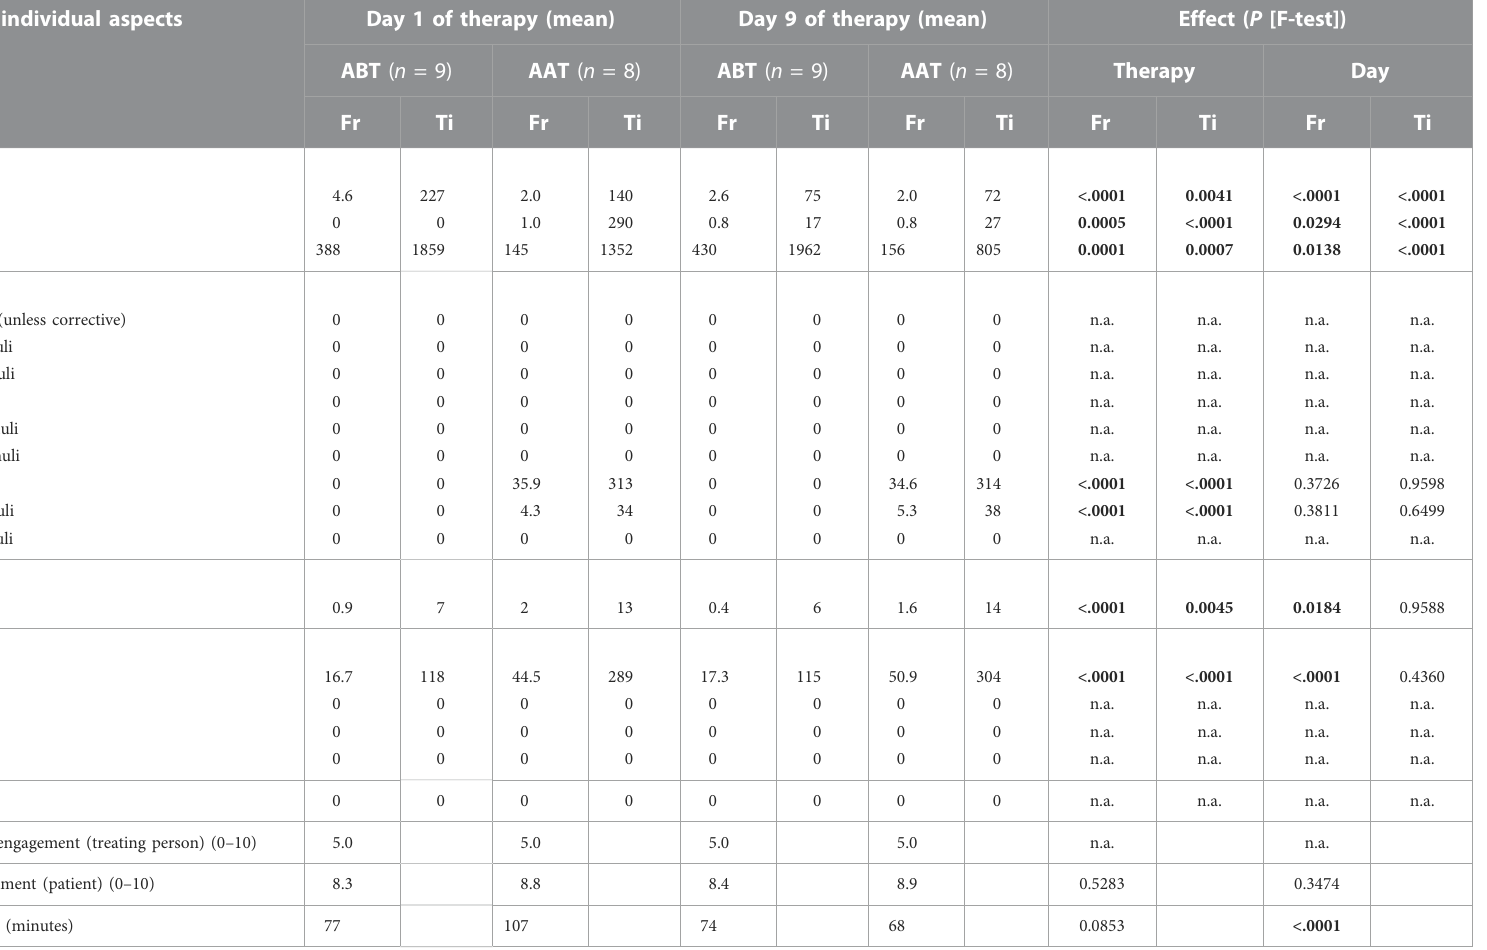
TABLE 3 Ther-I-Act observations: Variation of the therapeutic interaction by the humanoid robot with therapy and over time ( n = 17). Themes and individual